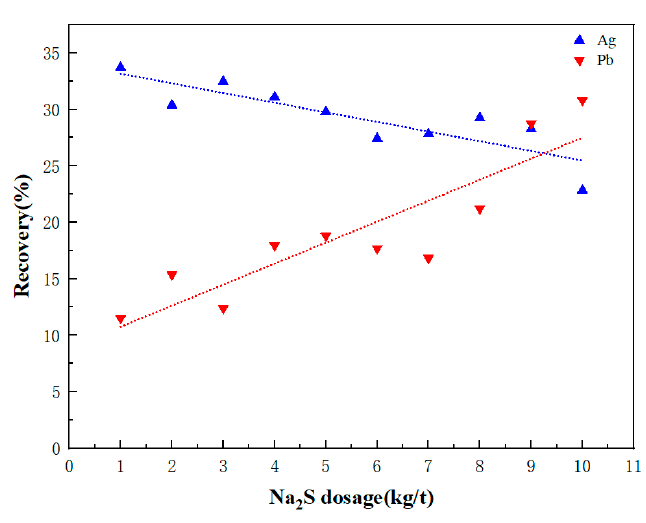
Figure 3. Flotation recovery of total Ag and Pb at different dosages of Na 2 S.